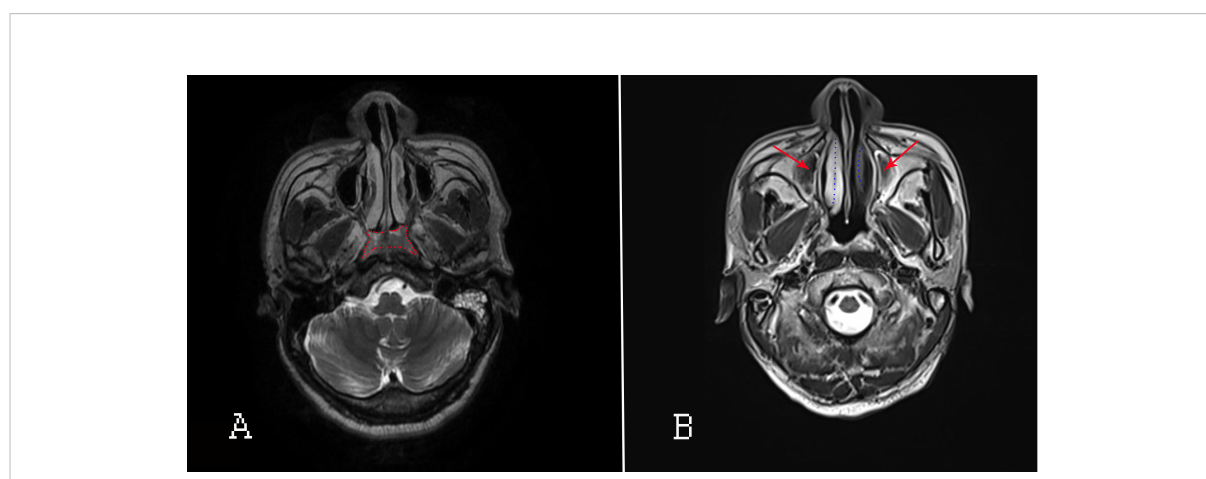
FIGURE 3 MRI of the nasopharyngeal passages and skull base. (A) Before RT; the red area indicates nasopharyngeal lesions. (B) After RT. Red arrows: in fl ammation of the maxillary sinus; blue dotted lines: oedematous IT (right) and atrophied IT